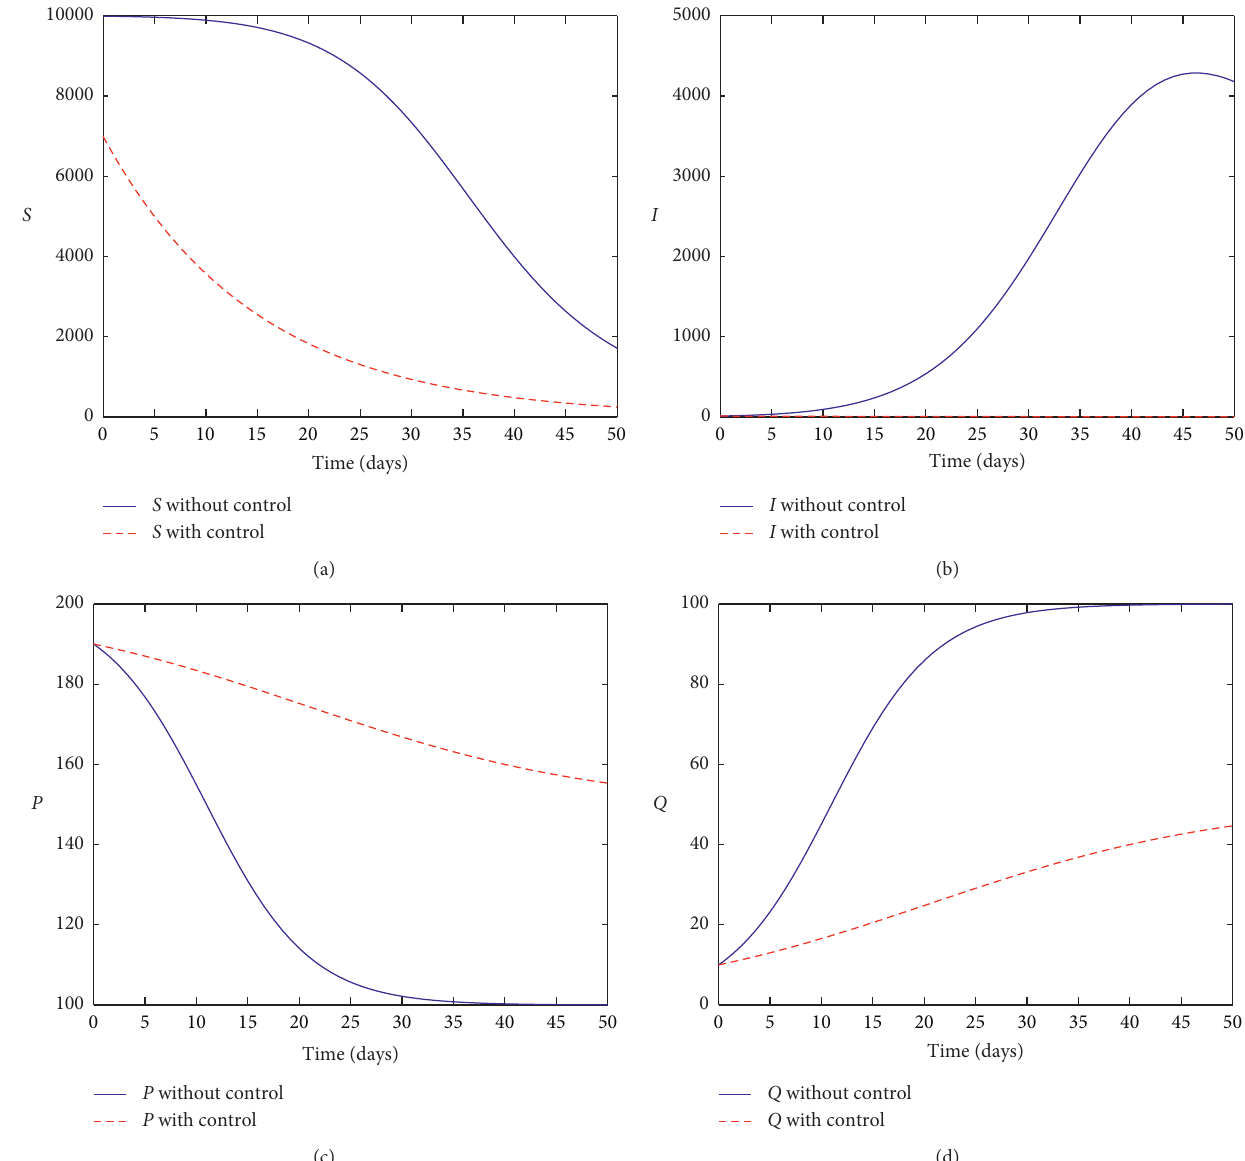
Figure 2: Graphical illustration of possible dynamics of model (1) and multiple control model